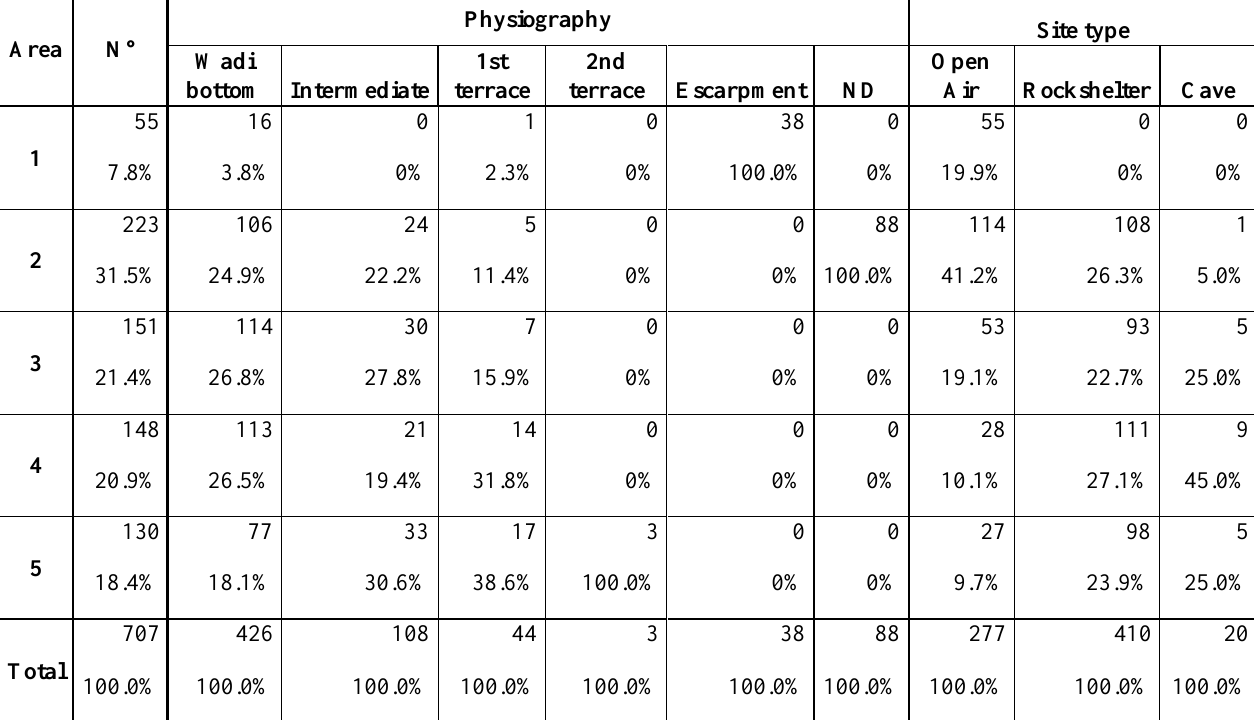
Table 1. Physiography and Site type of rock art contexts, by